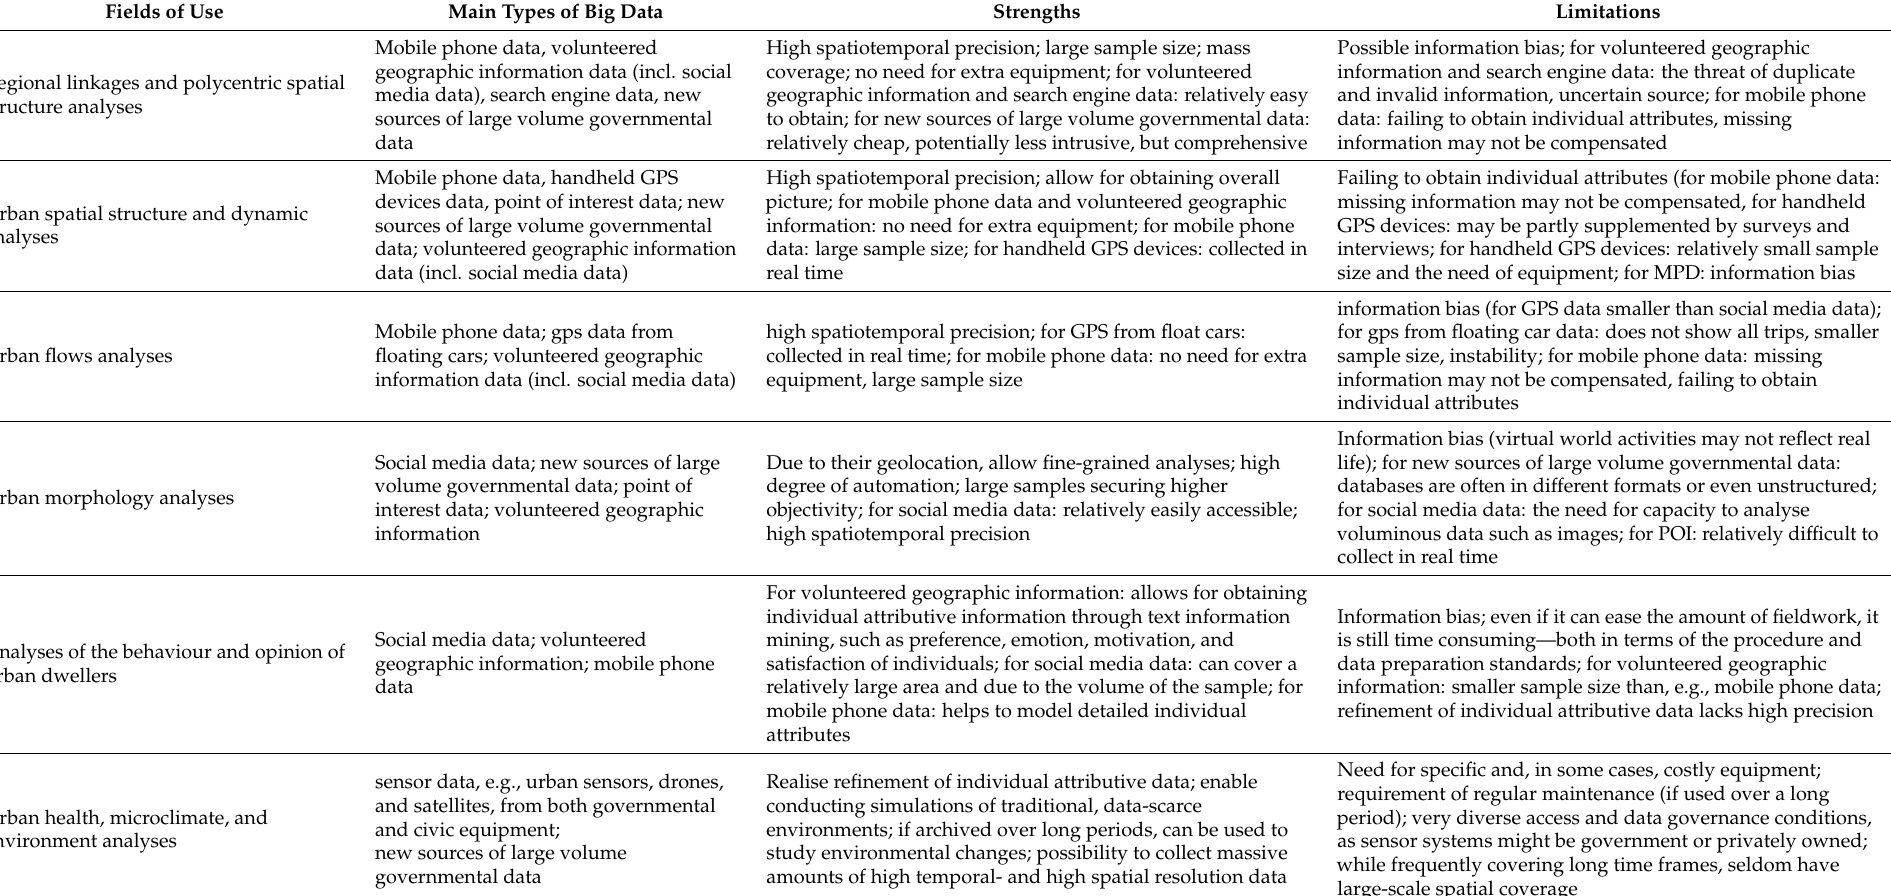
Table 2. Use of urban big data in design and planning of